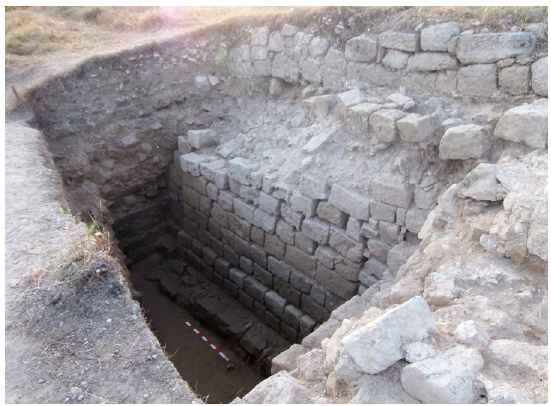
Figure 2. Trimammium , trench “C”: the wall where the amphora fragment was found. In 2017, the research concentrated on part of the outside of the fortification walls. From the earliest wall, fragments of it with an angle and part of the wall of a tower were explored to the level between the substructure and superstructure. Beneath the surface layer, there was a massive layer with evidence of destruction, stones from the fortification wall, and very few findings (mostly pottery fragments) of Late antique date. Below, cultural layer around 70–80 cm thickness provided most of the findings for the excavations in 2017, and about 90% of the pottery. All datable findings – fibulae, buckles, lamps, coins – are from the sixth century AD. This layer also provided the upper part of an amphora with dipinti , which constitutes the object of the present